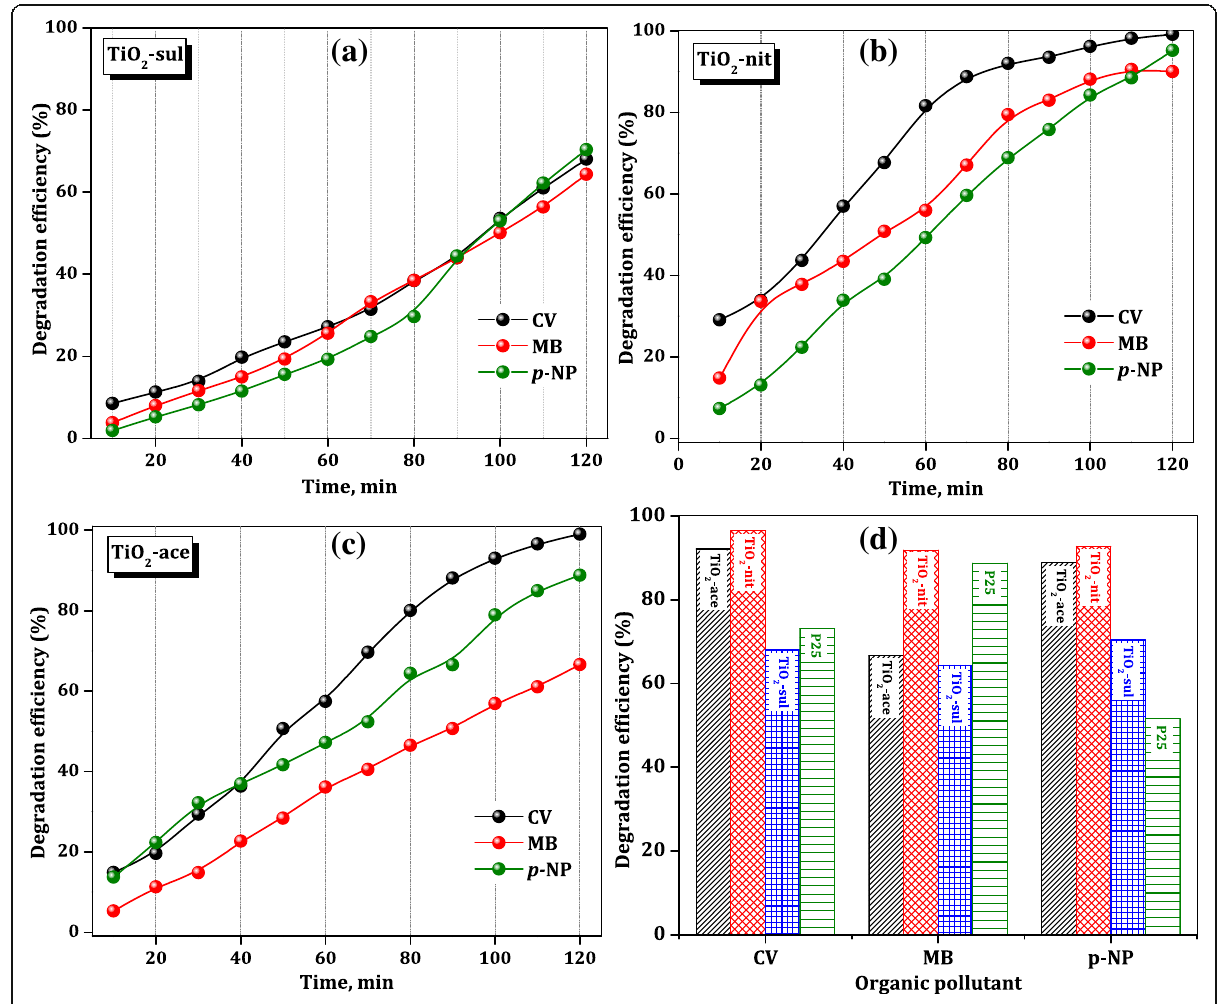
Fig. 8 Photocatalytic degradation efficiency of TiO 2